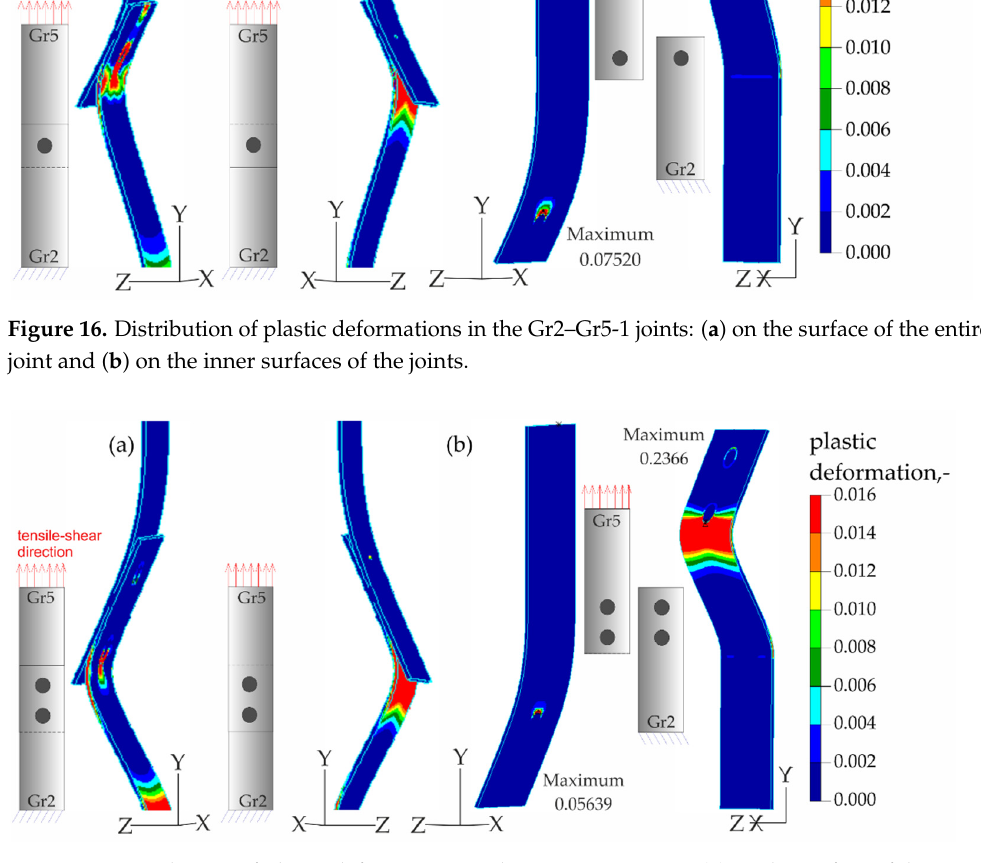
Figure 17. Distribution of plastic deformations in the Gr2–Gr5-2 joints: ( a ) on the surface of the entire joint and ( b ) on the inner surfaces of the joints.